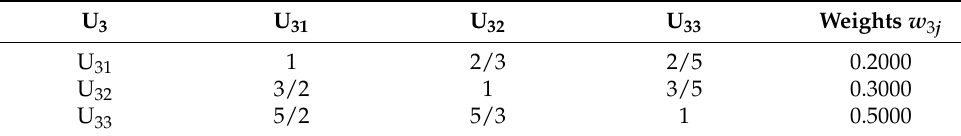
Table 8. Judgment matrix U 3 –U 3 j